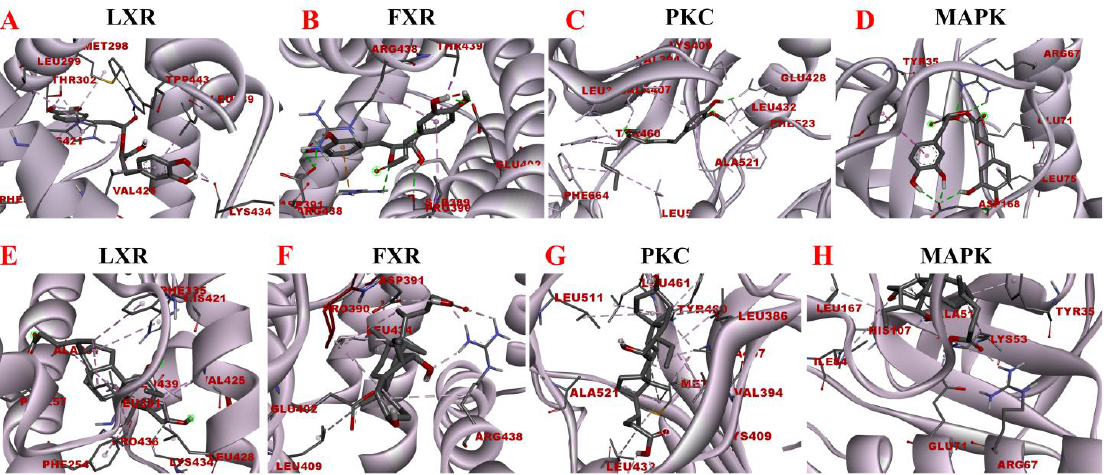
Figure 10. Molecular docking models of rosmarinic acid and obeticholic acid binding to LXR, FXR, PKC, and MAPK. ( A – D ) correspond to the binding models of rosmarinic acid with LXR, FXR, PKC, and MAPK, respectively. ( E – H ) correspond to the binding models of obeticholic acid with LXR, FXR, PKC, and MAPK, respectively. Table 2. Intermolecular interactions between rosmarinic acid and LXR, PKC, FXR, and MAPK. Proteins